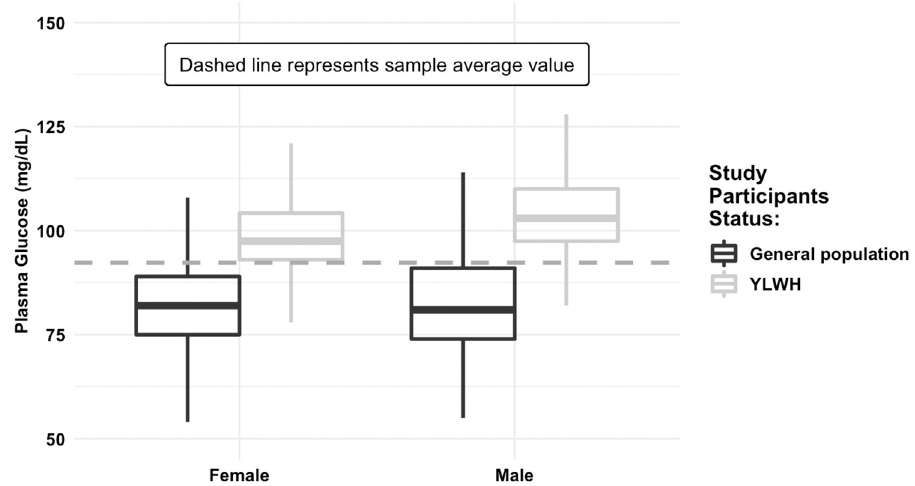
Fig 2. Plasma glucose levels among (fasting) study participants, stratified by BMI. Source: 2016 UHS (n = 486) and 2019/2020 (n = 370) STEP surveys, Cambodia.